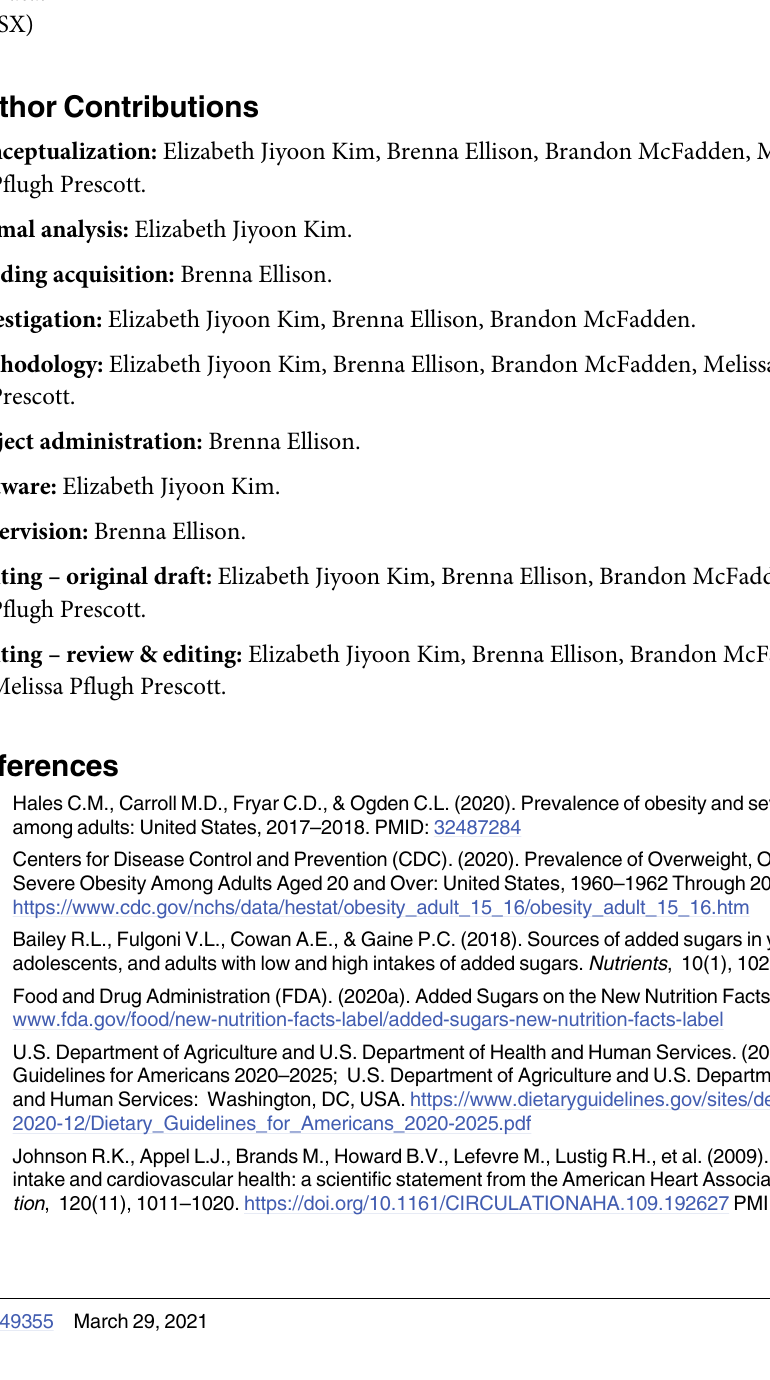
S1 Table. List of products with total and added sugars in grams. S2 Table. Primary reason for wanting added sugars content by product category (both information treatments combined). S3 Table. Primary reason for not wanting added sugars content by product category (both information treatments